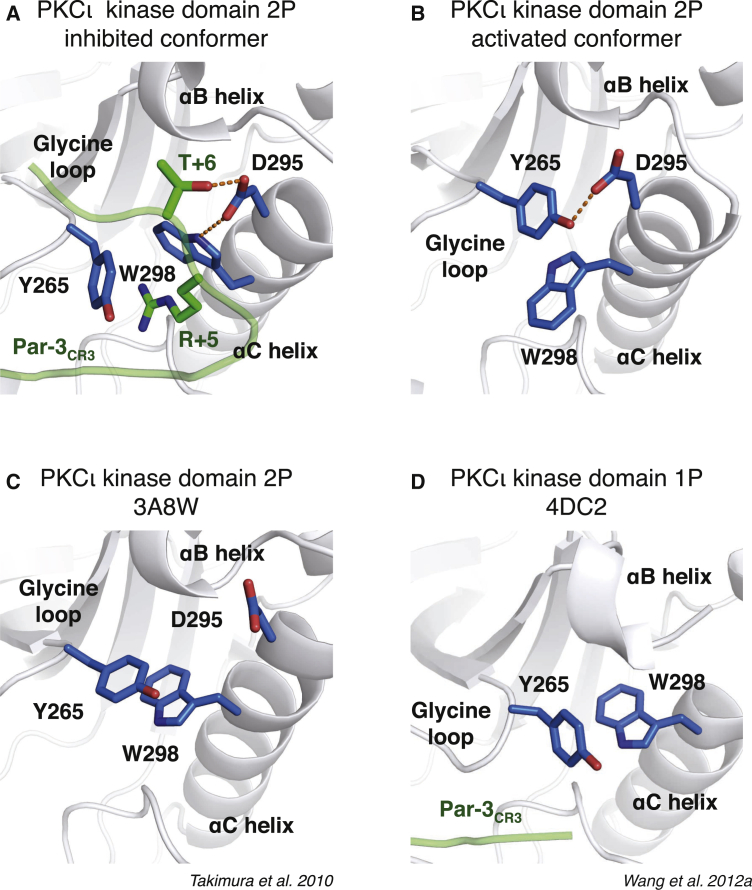
Close-Up View of the Par3 CR3 Inhibitory Arm Pocket Bound to PKCιKD-2P with Other PKCιKD Structures(A) Close up of the inhibitory R+5 hook of Par3CR3 clamped by side chains Y265PKCι (P loop) and W298PKCι (αC helix) of PKCιKD-2P (gray cartoon, major interaction residues are shown as blue sticks). Key structural features of the PKCιKD-2P are labeled. Hydrogen bonds between key side chains are shown as dashed red lines.(B) Close up of R+5 pocket in the active conformation of AMPPCP-bound PKCιKD-2P structure. Hydrogen bonds between key side chains are shown as dashed red lines.(C) Close up of R+5 pocket in the previously solved ATP-bound PKCιKD-2P structure (PDB: 3A8W) (Takimura et al., 2010).(D) Close up of PKCιKD-1P K283R mutant within its ATP cleft (PDB: 4DC2) (Wang et al., 2012a).See also Figure S3C for refined nucleotide analog electron density and Figure S3D for a comparison with a chemical inhibitor-induced PKCιKD-2P conformer.